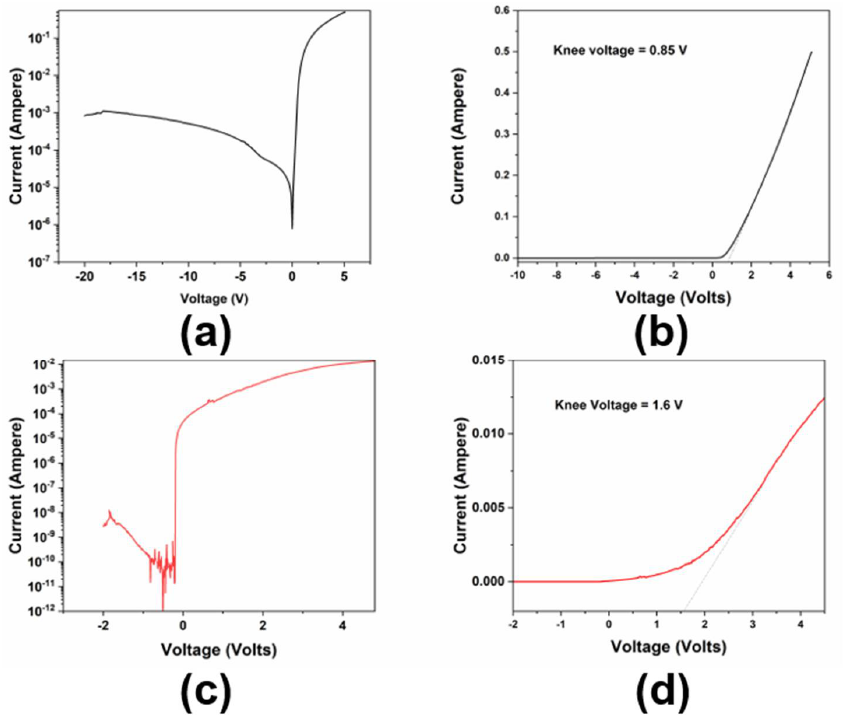
Figure 7. I-V characteristics of ( a , b ) n-Si/p-CIO heterojunction and ( c , d ) quartz p-CIO/n-ITO hetero- junction with knee voltages.